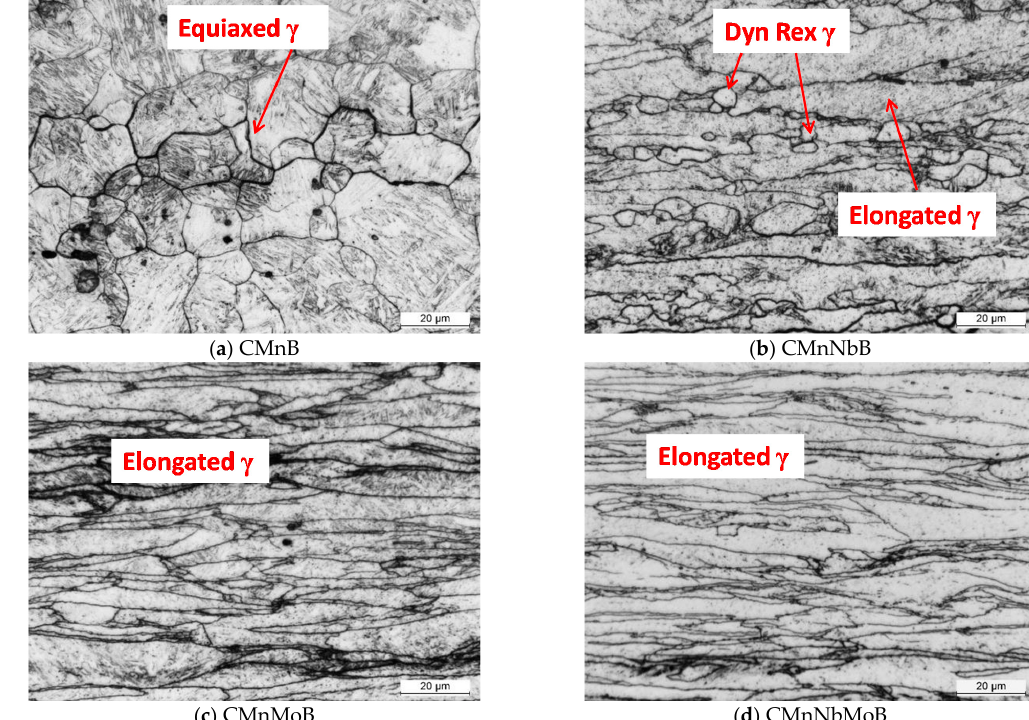
Figure 4. Optical micrographs of the austenite structure after quenching corresponding to ( a ) CMnB, ( b ) CMnNbB, ( c ) CMnMoB and ( d ) CMnNnMoB steels (picric acid etching is used).